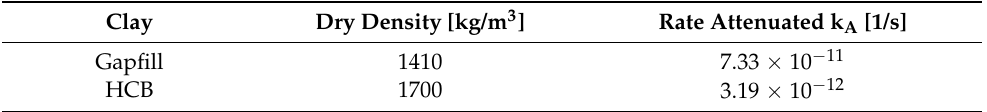
Table 3. Attenuated reaction rate